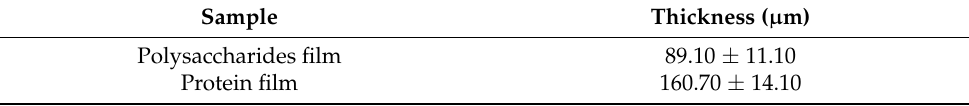
Table 1. Thickness of films, the results are reported as the mean ± sd.